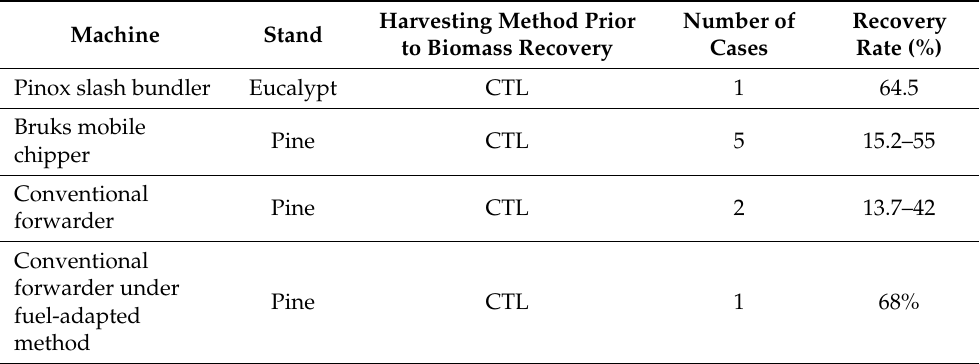
Table 4. Biomass recovery rates for different harvesting